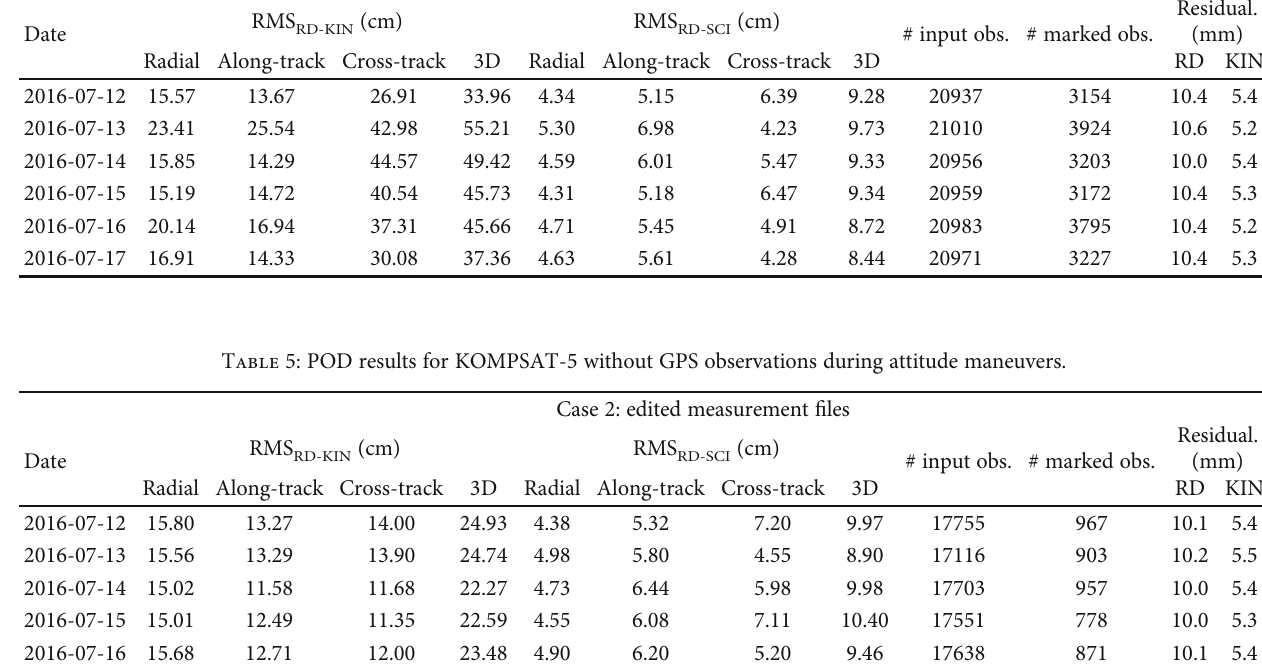
Table 4: POD results for KOMPSAT-5 with GPS observations during attitude maneuvers. Case 1: raw measurement fi les